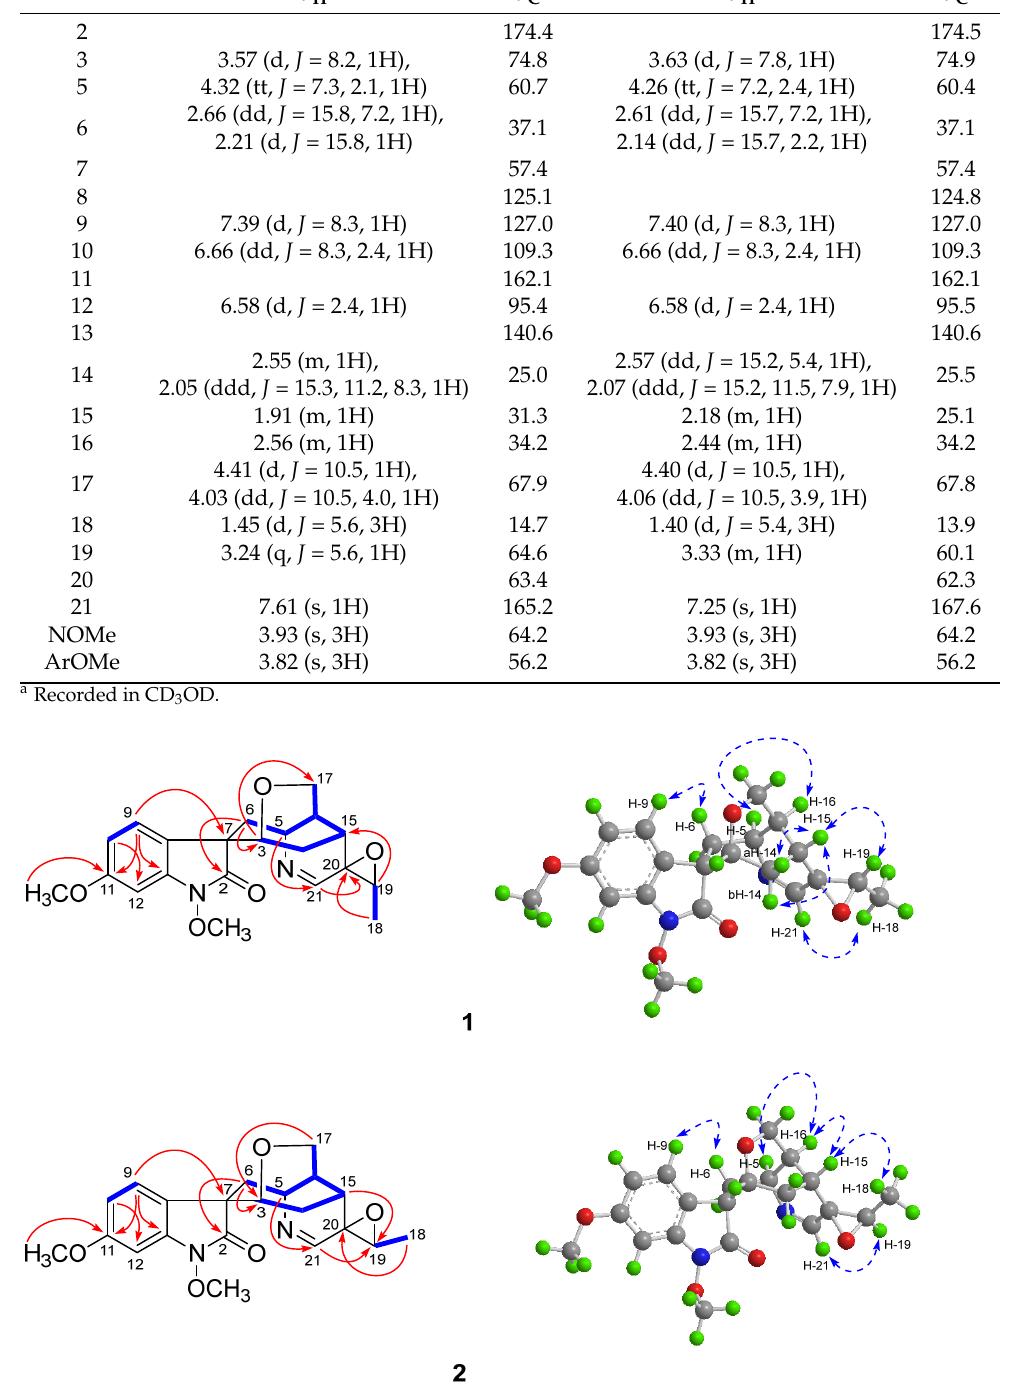
Figure 2. Selective HMBC ( Figure 2. Selective HMBC ( ), 1 H- 1 H COSY ( ), and ROESY ( ) correlations of compounds ), 1 H- 1 H COSY ( Figure 2. Selective HMBC ( ), 1 H- 1 H COSY ( ), and ROESY ( ) correlations of compounds ), and ROESY ( Figure 2. Selective HMBC ( ), 1 H- 1 H COSY ( ), and ROESY ( ) correlations of compounds ) correlations of compounds 1 Figure 2. Selective HMBC ( ), 1 H- 1 H COSY ( ), and ROESY ( ) correlations of compounds 1 and 2 . 1 and 2 . and 2 1 and 2 . 1 and 2 .